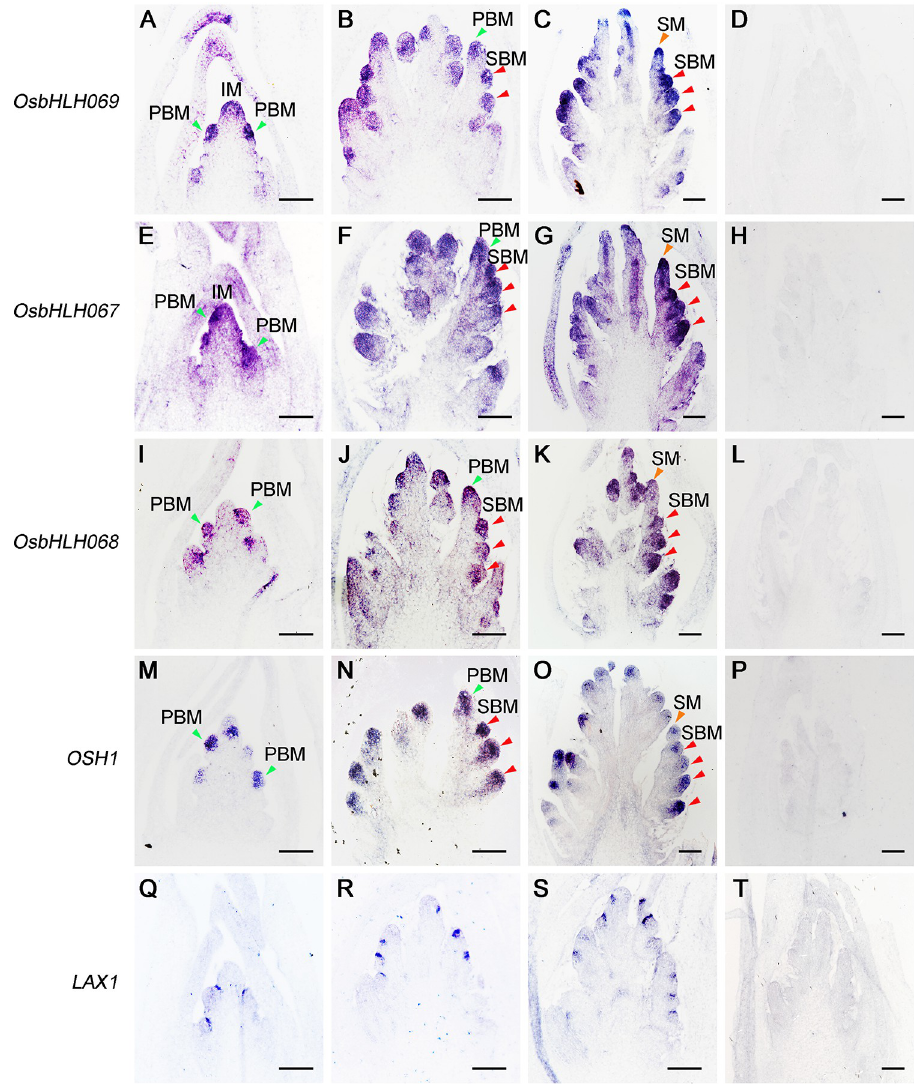
Fig 4. Spatial expression patterns of OsbHLH067 , OsbHLH068 , and OsbHLH069 in young panicles. In situ localization of OsbHLH069 (A to D), OsbHLH067 (E to H), OsbHLH068 (I to L), OSH1 (M to P), and LAX1 (Q to T) in developing inflorescences. (D), (H), (L), (P) and (T) The sense probes of OsbHLH069 (D), OsbHLH067 (H), OsbHLH068 (L), OSH1 (P), and LAX1 (T) served as controls. (A), (E), (I), (M) and (Q) A developing inflorescence at the primary branch meristem (PBM, green triangle) differentiation stage. (B), (F), (J), (N) and (R) A developing inflorescence at the secondary branch meristem (SBM, red triangle) differentiation stage. (C), (G), (K), (O) and (S) A developing inflorescence at the spikelet meristem (SM, yellow triangle) initiation stage. IM, inflorescence meristem. Bars = 100 μ